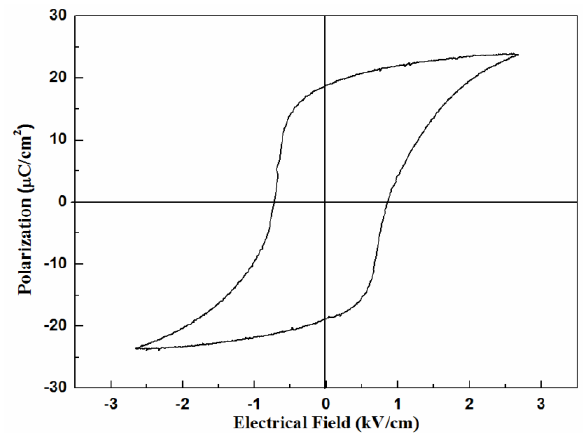
Figure 6. XRD pattern of the sample sintered at 1100 °C.